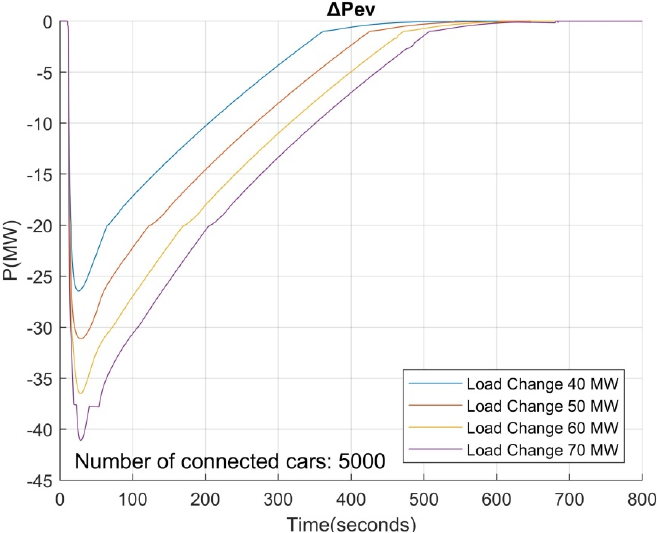
Figure 13. Total power generation from a certain number of PEVs with respect to load change.